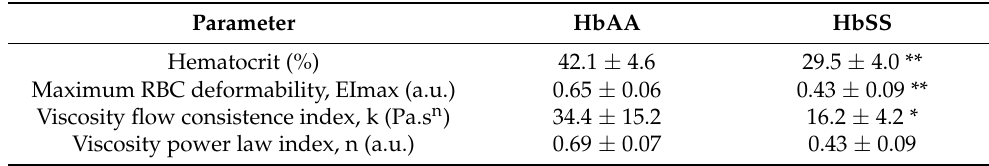
Table 1. Blood rheological parameters for HbAA and HbSS. Significant difference between the two groups: * represents p < 0.05, and ** represents p < 0.01. Parameter HbAA HbSS Hematocrit (%) Maximum RBC deformability, EImax (a.u.) Viscosity flow consistence index, k (Pa.s n